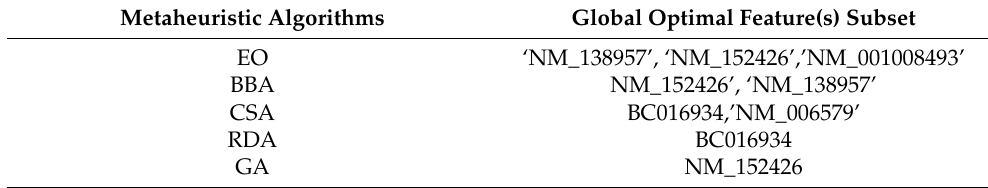
Table 7. The five state-of-the-art metaheuristic algorithms obtained a listing of five optimal global subsets of